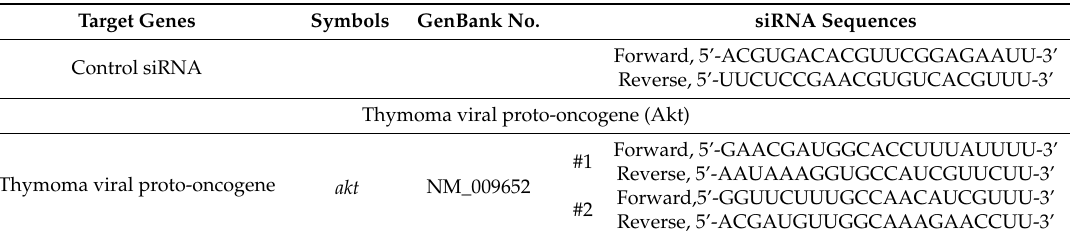
Table 1. Sequences of